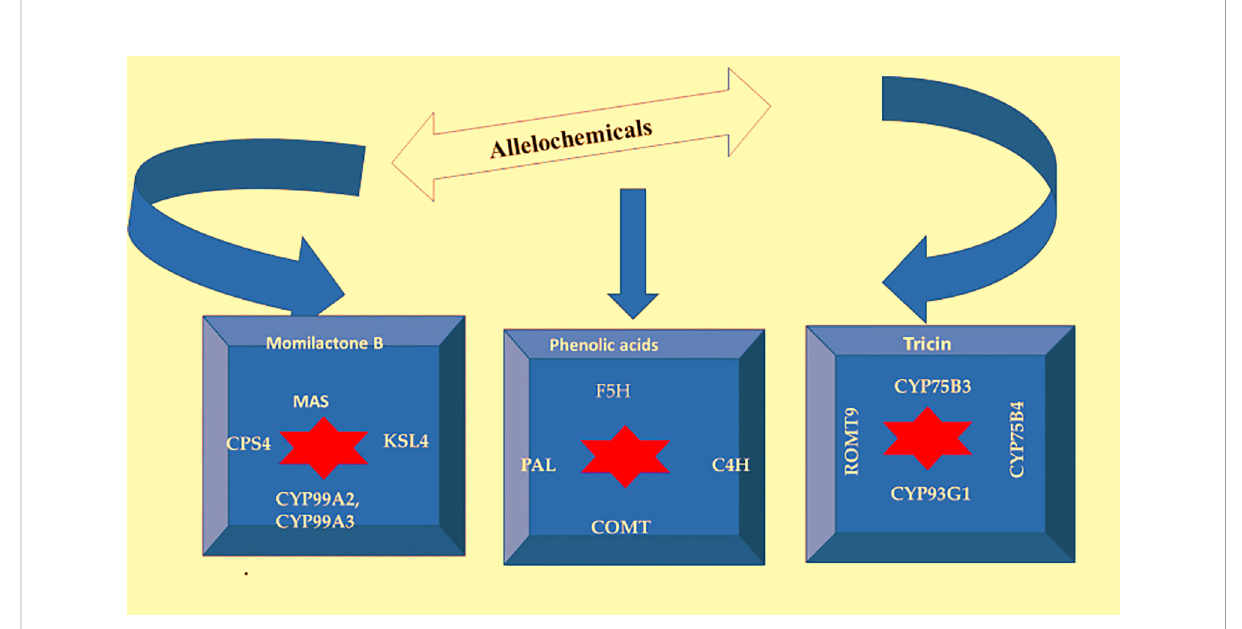
FIGURE 3 Genes involved in the biosynthesis pathways of momilactone B, phenolics, and tricin [CPS4; gene encoding syn-copalyl diphosphate synthase, KSL4; gene encoding syn-pimara7,15-diene synthase, MAS; gene encoding momilactone A synthase, CYP99A3 and CYP99A2; gene encoding 9- beta-pimara-7,15-diene oxidase, COMT- Caffeic acid O -methyltransferases, PAL- phenylalanine ammonia-lyase, Cinnamate-4-hydroxylase (C4H), F5H-Ferulic acid 5-hydroxylase, fl avonoid 3 ’ -monooxygenase; CYP75B3, fl avonoid 3 ’ -hydroxylase; CYP75B4, fl avonoid 3 ’ ,5 ’ - O - methyltransferase; ROMT9 and CYP93G1; cytochrome fl avone synthase